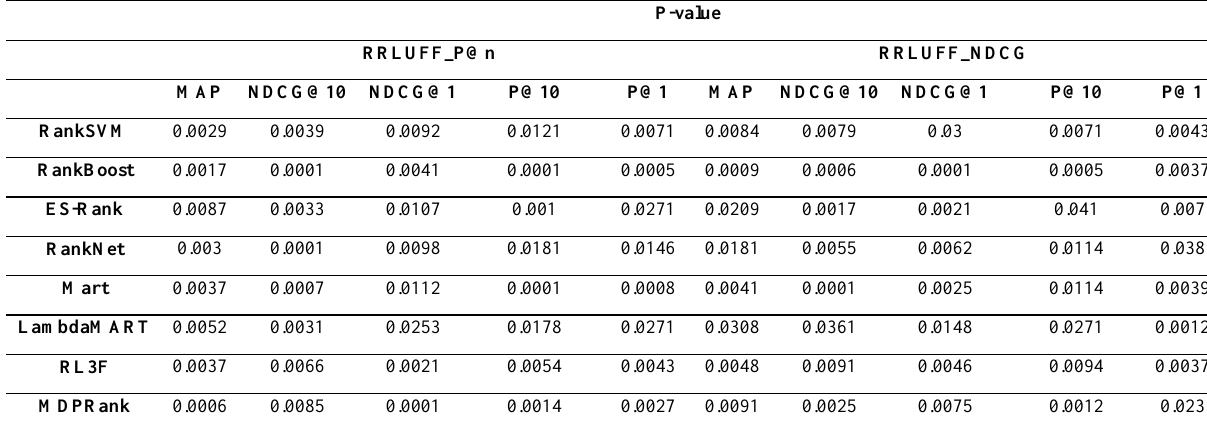
Table 1. The statistical significance of the p-value (paired t-test) between RRLUFF and other compared methods on OHSUMED dataset.